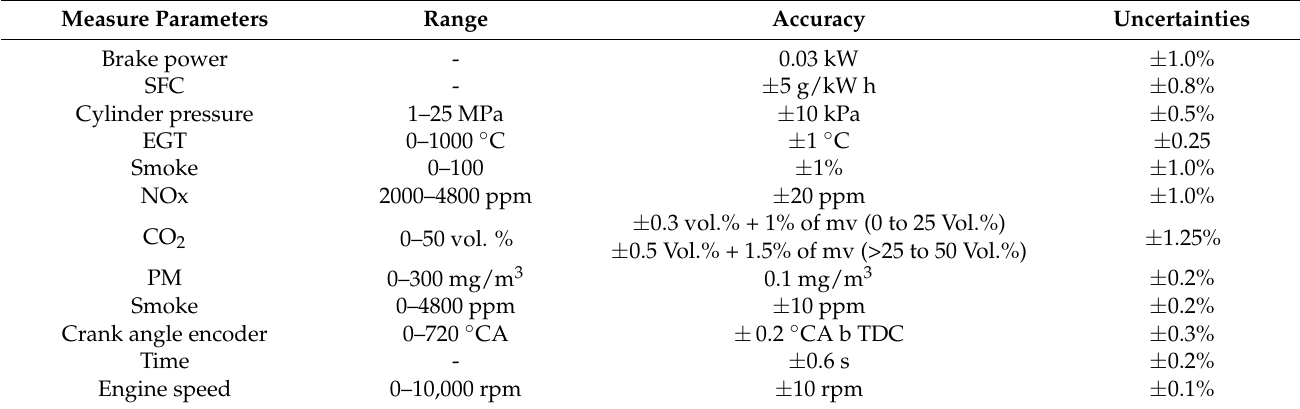
Table 3. Uncertainly error analysis during